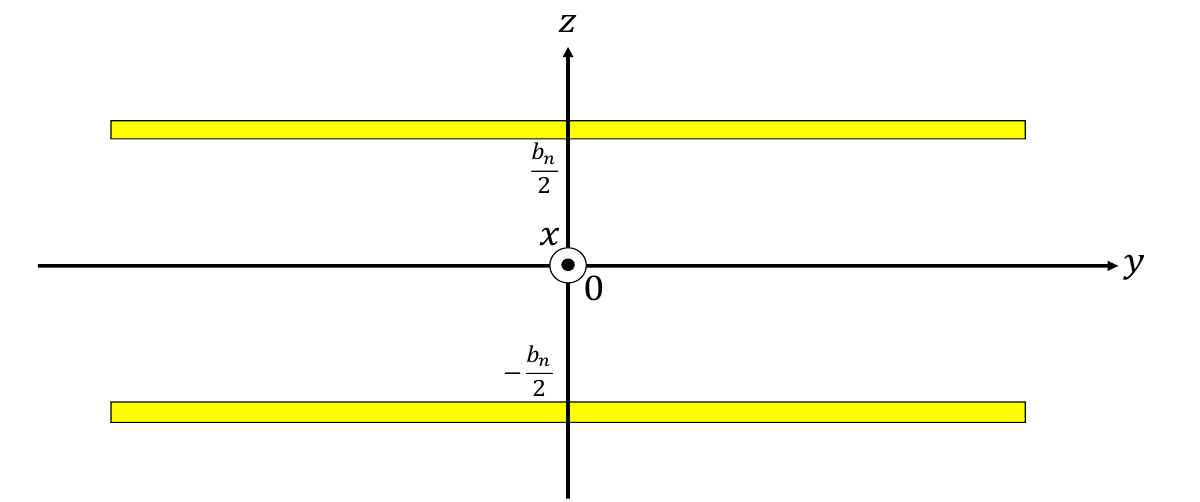
Figure 7. Coordinates for the clearance between the two planes.